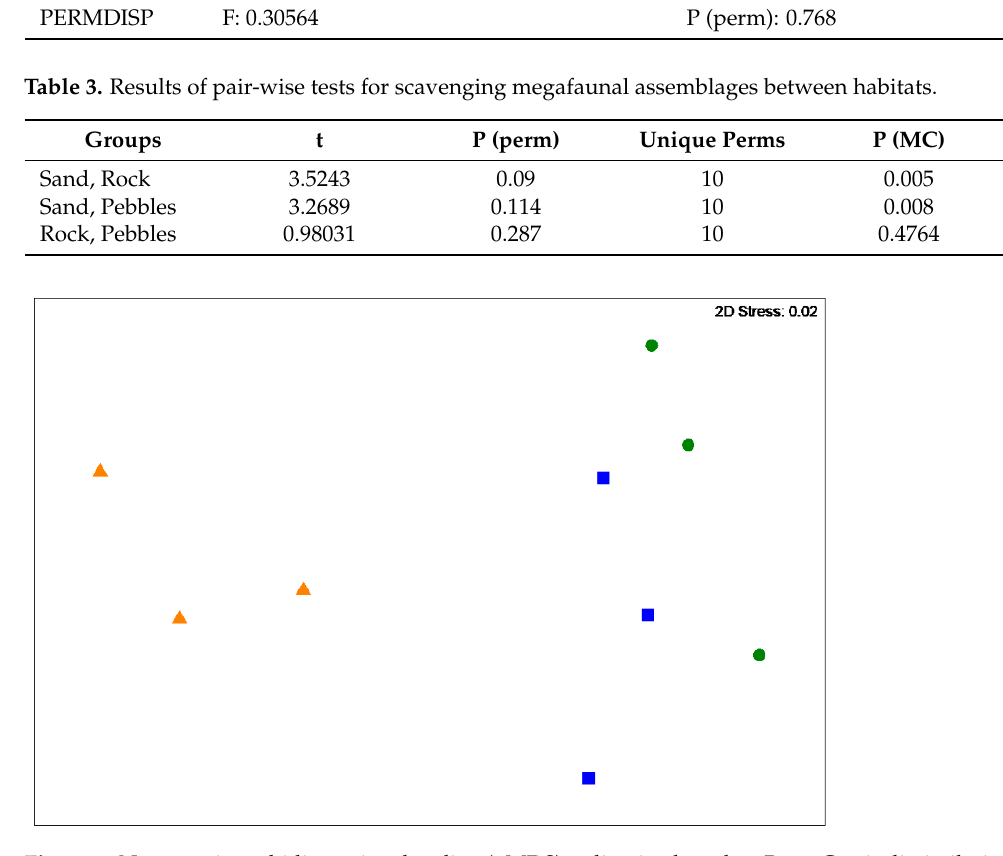
Figure 4. Non-metric multidimensional scaling (nMDS) ordination based on Bray–Curtis dissimilarity of centroids (calculated with the four replicates of scavenging megafaunal assemblages in three different habitats). (a) Orange triangles: sand; (b) Green dots: rock and (c) Blue squares: